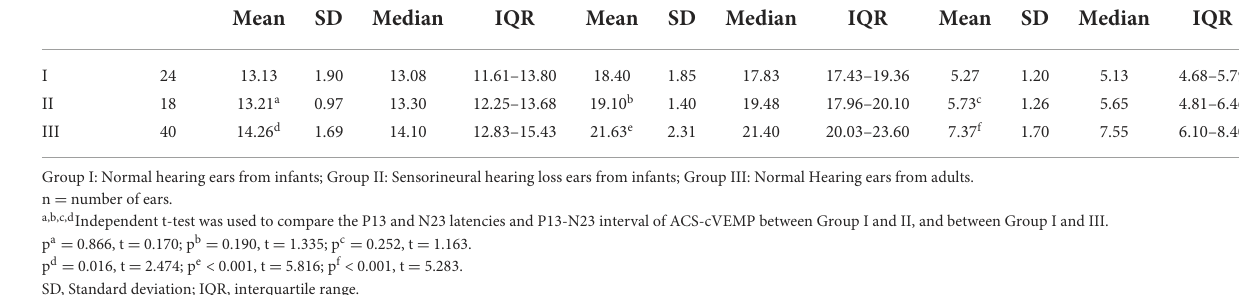
TABLE 3 The P13 and N23 latencies and P13-N23 interval of ACS-cVEMP in three groups. Group